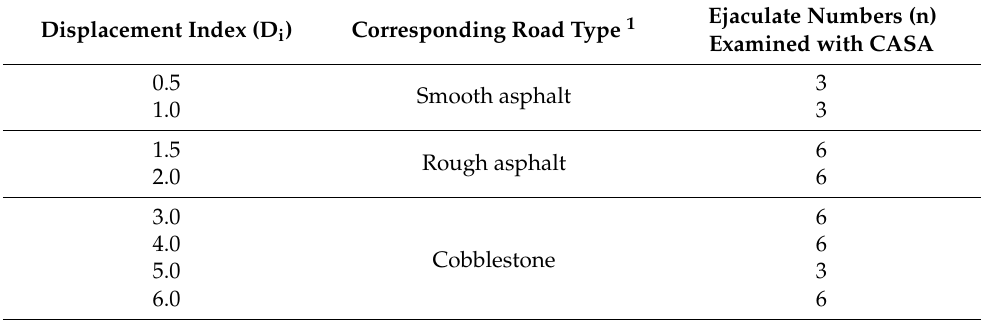
Table 1. Experimental design: every examined ejaculate was split into 14 subsamples ( n = 546 in total) and treated for 13 different durations (0.5 to 12 h) with rising vibration intensities (D i ). The unshaken sample served as a control (duration = 0